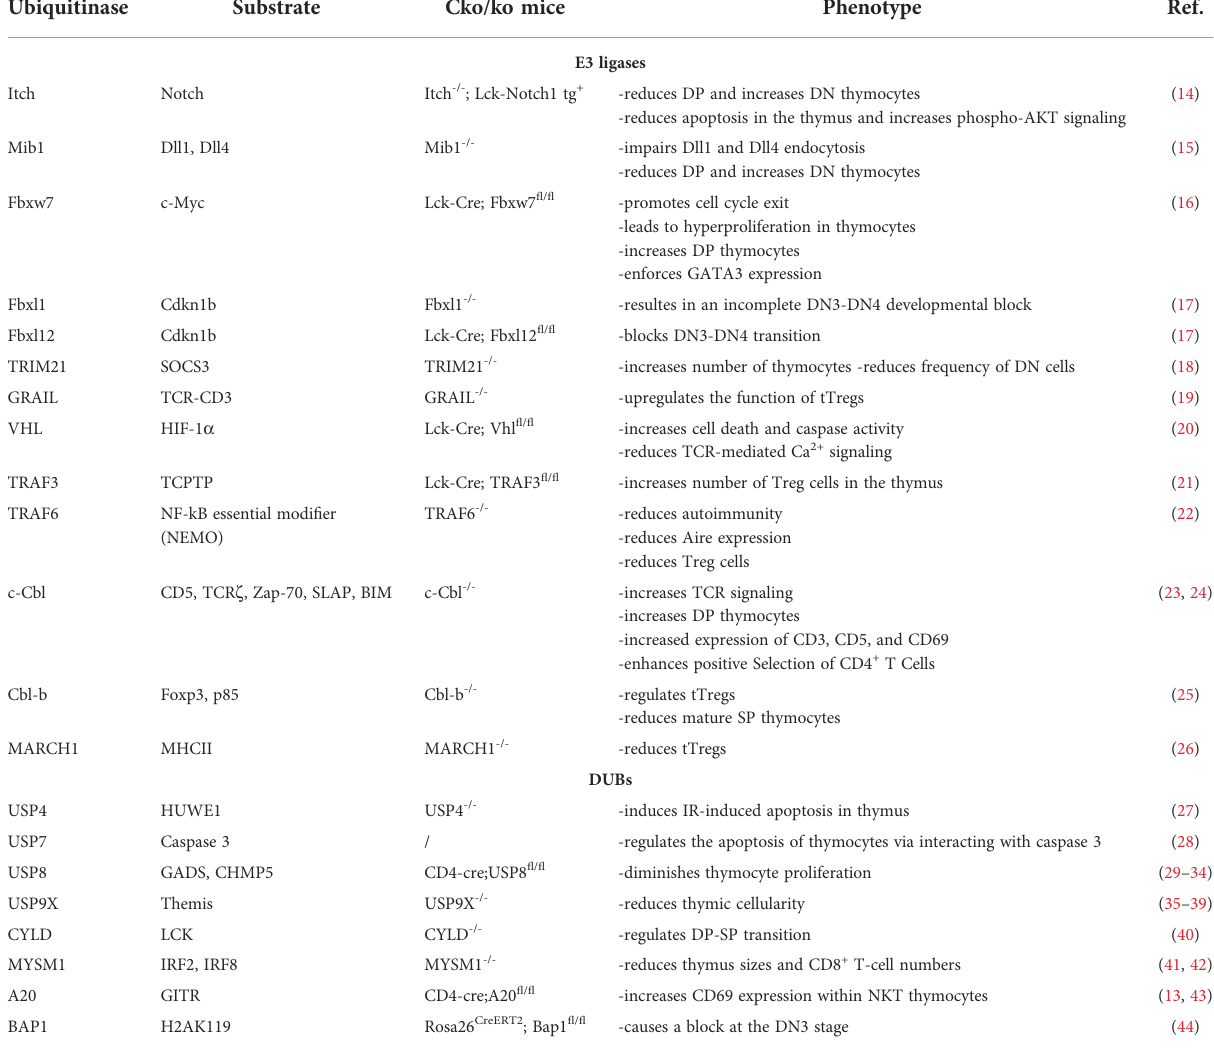
TABLE 1 List of E3 ligases and DUBs that modulate T cell development.